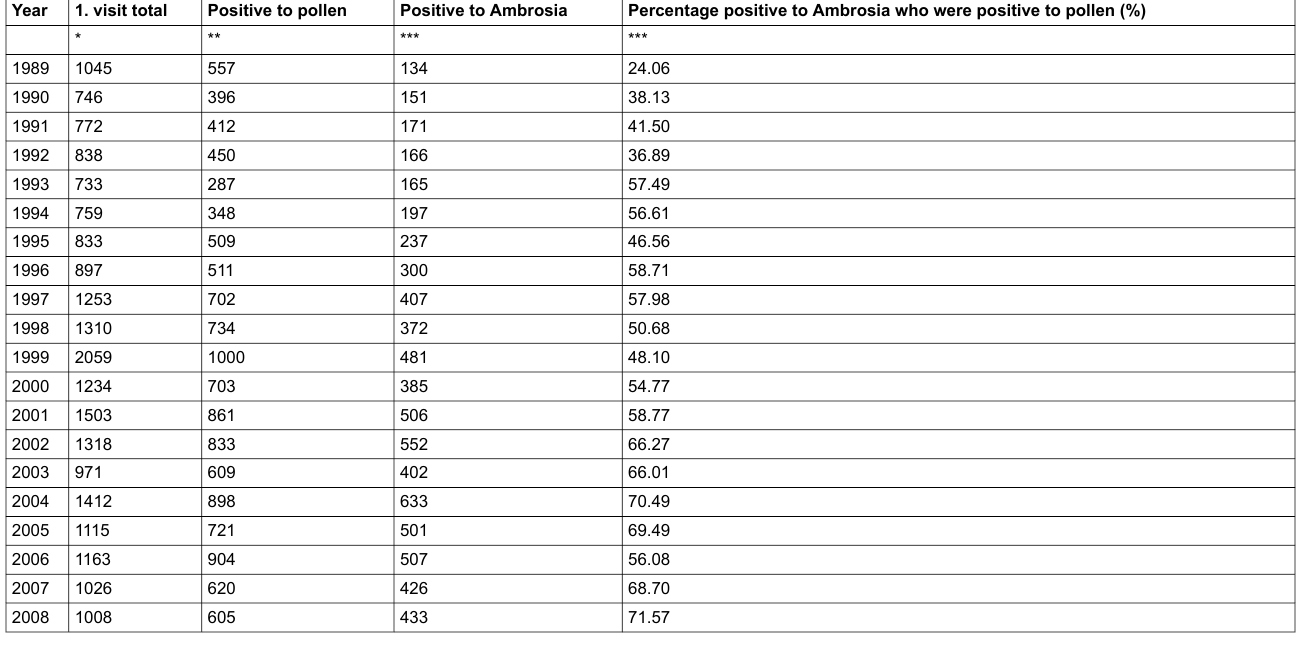
Table 1: Number of patients who attended the allergy unit of the hospital in Legnano for the first time. Sensitisation was tested by a skin prick test (SPT). The significance of the trends was calculated using the Mann-Kendall trend test: p <0.05*, p <0.01**, p <0.001***. Year